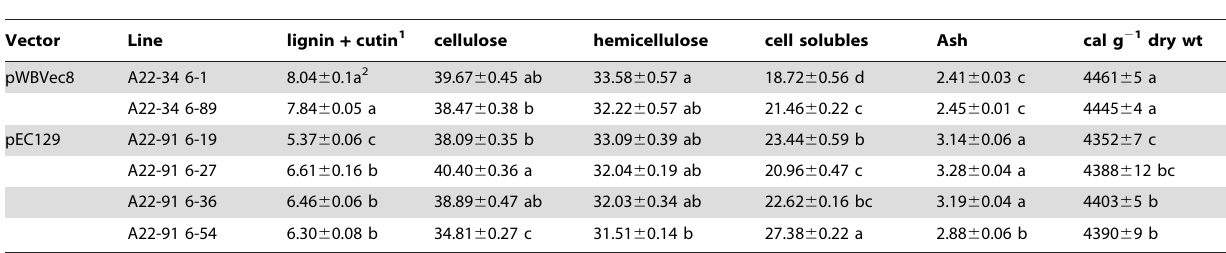
Table 1. Fiber analysis of CAD silenced transformants.